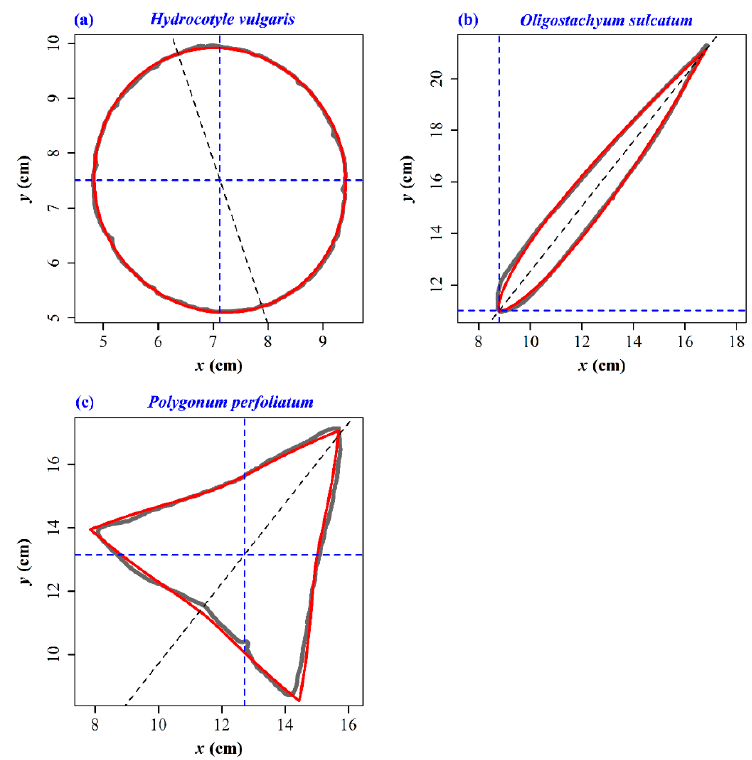
Figure 7. Gielis fit to the leaf edge data of three species of plants. ( a ) H. vulgaris ; ( b ) O. sulcatum ; ( c ) P. perfoliatum . The gray curve represents the scanned (observed) leaf edge; the red curve represents the predicted leaf edge by the Gielis equation; the intersection of two blue dashed lines represents the polar point of the Gielis equation; the gray dashed line represents the rotated straight line that was the previous x -axis for a standard Gielis shape.